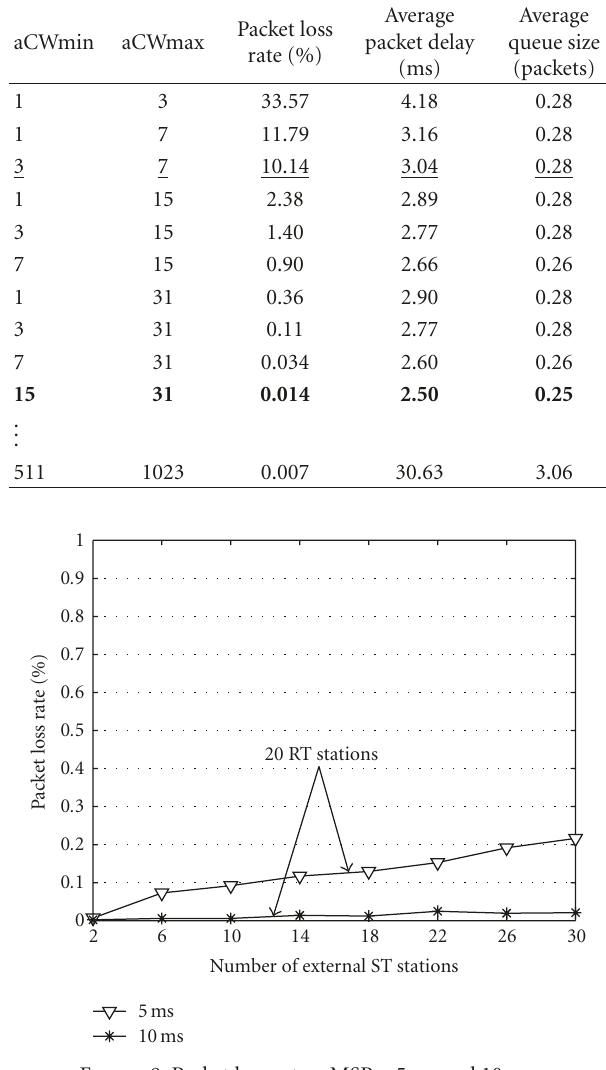
operating together with 2, 6, 10, 14, 18, 22, 26, and 30